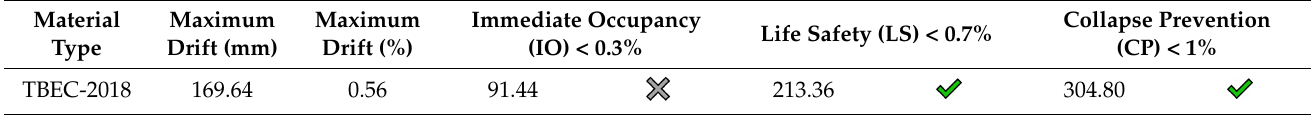
Table 15. Analysis translation results and limit values for the 2011 Van